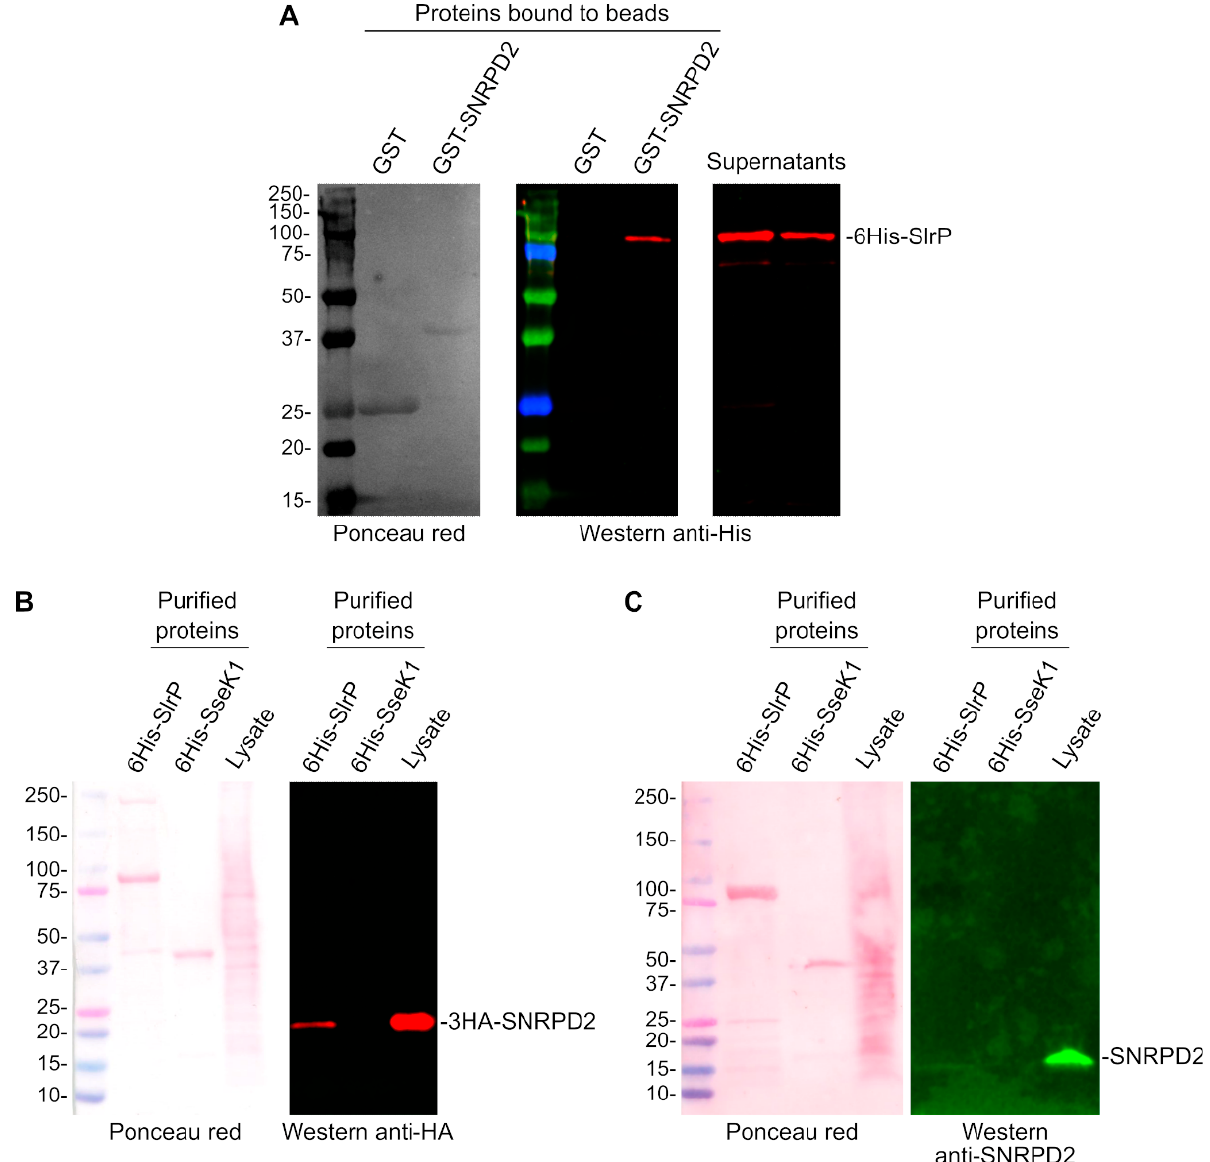
Figure 2 . Confirmation of the interaction of SNRPD2 with SlrP. ( A ) 6His-SlrP was incubated with GST or GST-SNRPD2 bound to glutathione-agarose beads. Copurification of SlrP with SNRPD2 was detected by immunoblot with anti-His antibodies. ( B ) 6His-SlrP or 6His-SseK1 bound to Ni-NTA agarose beads were incubated with a cell lysate obtained from HeLa cells expressing 3HA-SNRPD2. Copurification of SNRPD2 with SlrP was detected by immunoblot with anti-HA antibodies. Ponceau S red staining was used as loading control. ( C ) 6His-SlrP or 6His-SseK1 bound to Ni-NTA agarose beads were incubated with a cell lysate obtained from HeLa cells. Copurification of SNRPD2 with SlrP was detected by immunoblot with anti-SNRPD2 antibodies. Ponceau S red staining was used as loading control. Sizes of molecular weight markers are shown in kDa. Results are representative of two independent